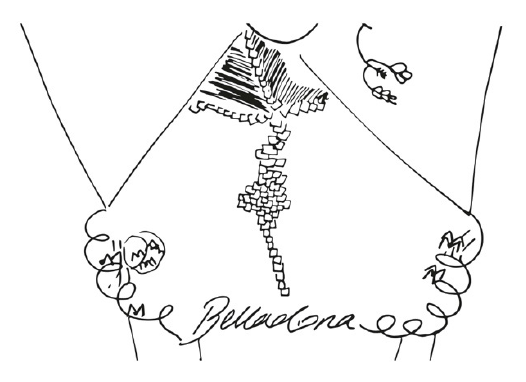
Figure 4. Prima Belladona